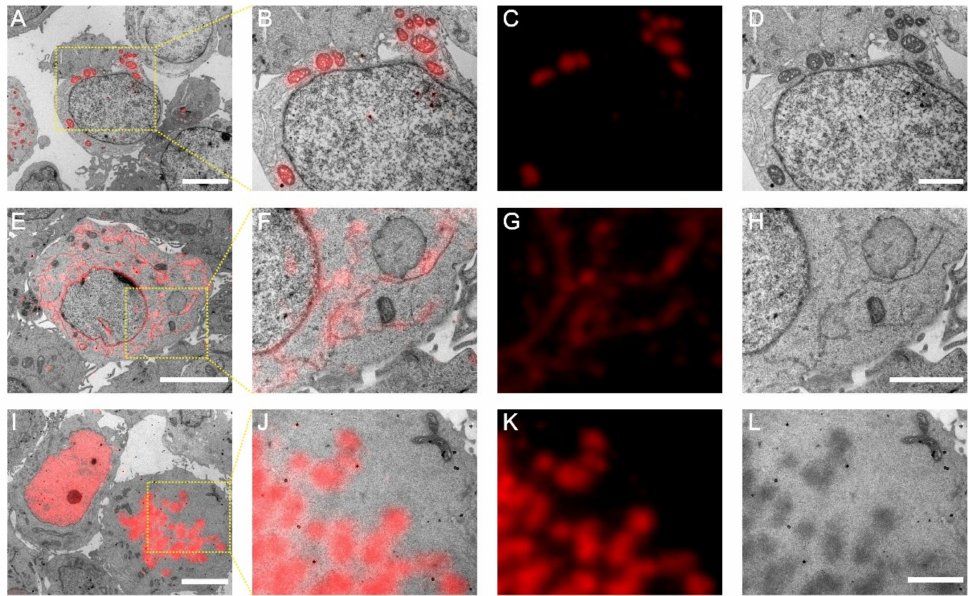
Figure 3. Post-Epon-embedding CLEM imaging with mScarlet-H. ( A ) CLEM image of the mitochon- drial matrix. Scale bar, 5 µ m. ( B – D ) Magnified CLEM, FM, and EM images of boxed area in ( A ). Scale bars, 2 µ m. ( E ) CLEM image of the endoplasmic reticulum sec61 β protein. Scale bar, 5 µ m. ( F – H ) Magnified CLEM, FM, and EM images of boxed area in ( E ). Scale bar, 2 µ m. ( I ) CLEM image of the nucleosome H2B protein. Scale bars, 5 µ m. ( J – L ) Magnified CLEM, FM, and EM images of boxed area in ( I ). Scale bars, 2 µ